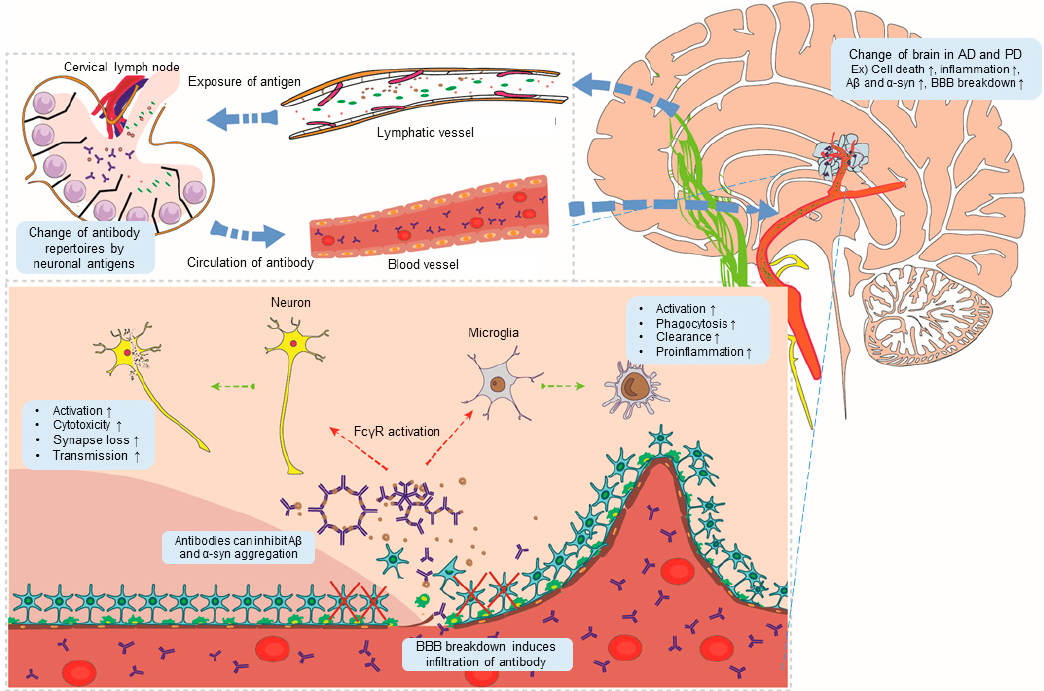
Figure 1. A model showing antibody-mediated pathogenesis of Alzheimer’s disease (AD) and Parkinson’s disease (PD). Changes in brain conditions in AD and PD (for example, cell death, inflammation, and aggregation of abnormal proteins) promote the outflow of neo-antigens through lymphatic vessels, causing changes in antibody repertoires. Damage to the blood–brain barrier (BBB) generated in AD and PD induces infiltration by antibodies. Antibodies activate FcR expression by brain cells, thereby promoting pathogenesis of AD and PD in the brain. A β : beta-amyloid; α -syn: α - synuclein.